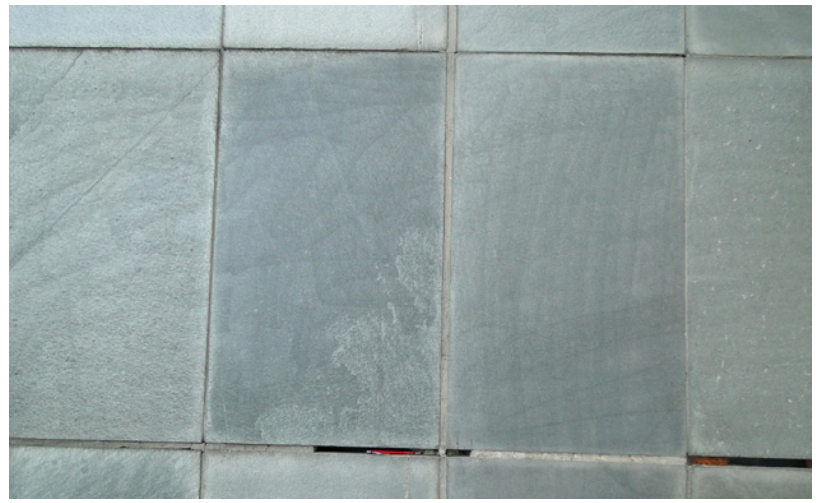
Figure 8. Phyllitic Quartzite facade panels (transverse length = 50 cm) (almost 60 years old); Alta Alta Quartzite / Quartzite/Norway.